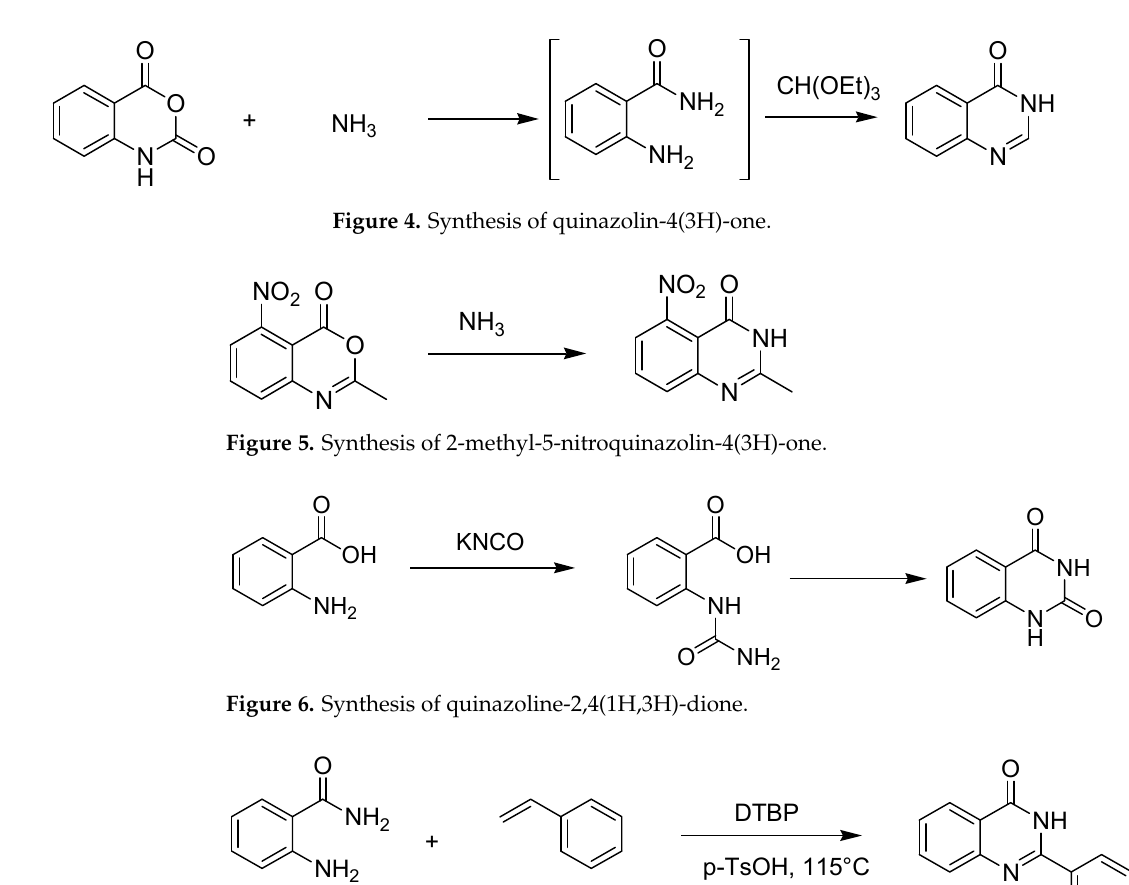
(vi) Synthesis of 2-phenylquinazolin-4(3H)-one: 2-aminobenzamide reacted with styrene